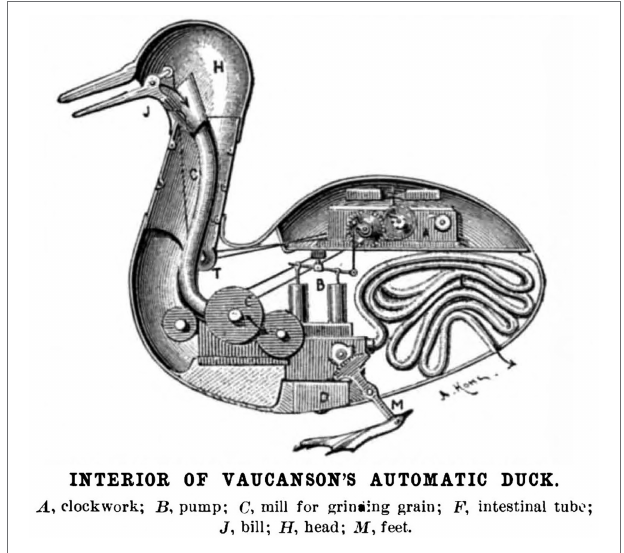
FIGURE 1 | Schematic of Vaucanson’s Canard Digérateur, or Digesting Duck . Inspired by Descartes’ idea that animals function much like a machine, Vaucanson created and unveiled a working model of the duck automaton pictured above in 1739. Two hundred years later in the 1940’s, Norbert Wiener theorized that all intelligent behavior functions as result of feedback mechanisms, much like a machine. The idea that humans function like machines has not changed for 400 years. It remains today a core assumption of neuroscience and artificial intelligence. (Image public domain). Source: Scientific American